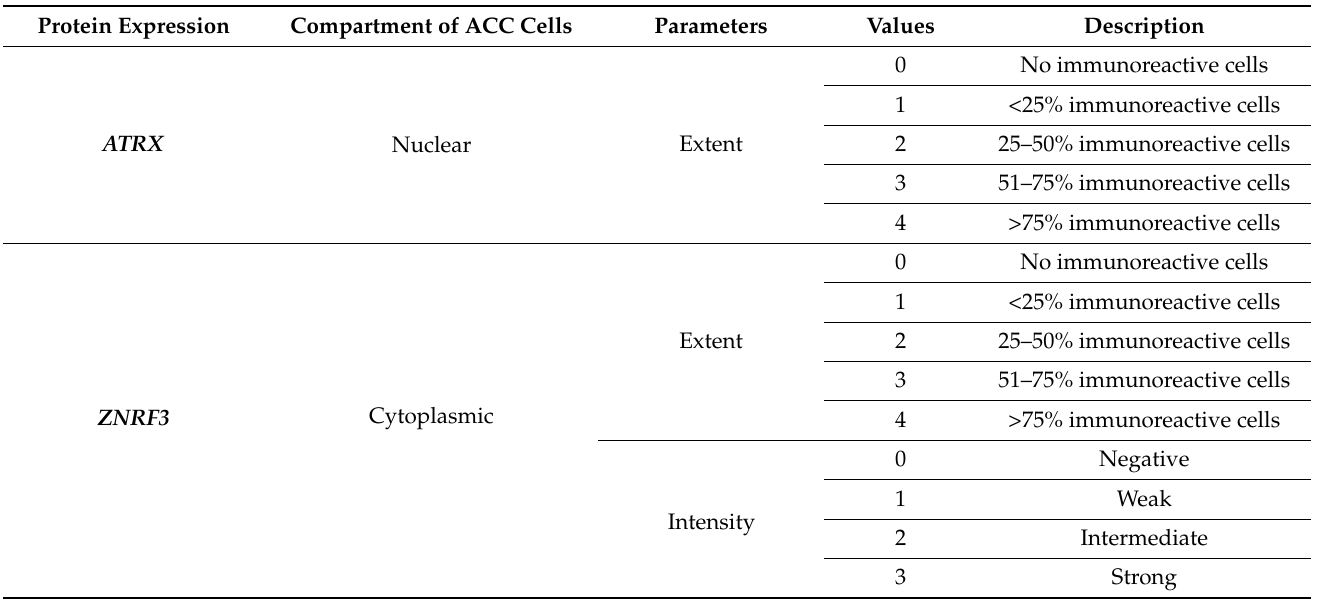
Table 2. Summary of analysis of immunohistochemistry used on TMA for ATRX and ZNRF3 expressions. Protein Expression Compartment of ACC Cells Parameters Values